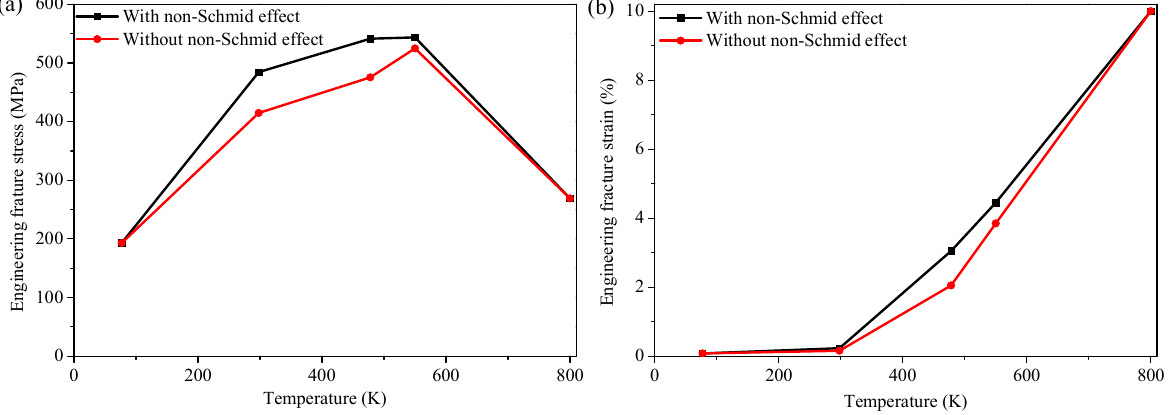
Figure 4. Influence of the NS effect on the engineering fracture stress ( a ) and engineering fracture strain ( b ) of tungsten at different temperatures.